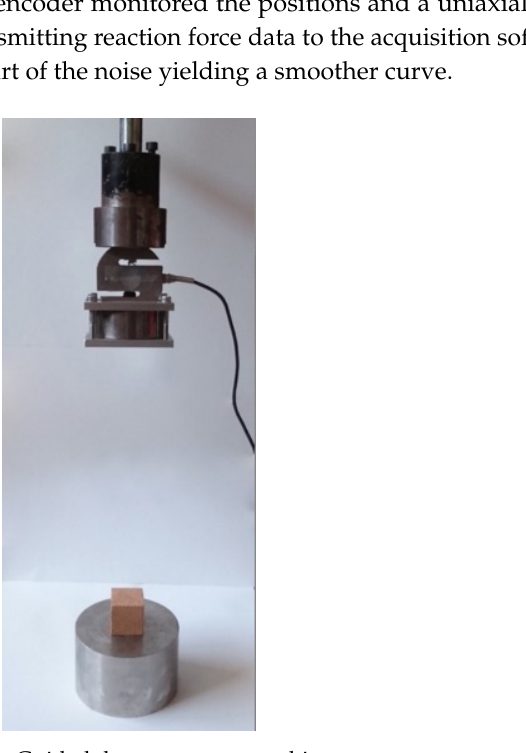
Figure 3. Guided droptower test